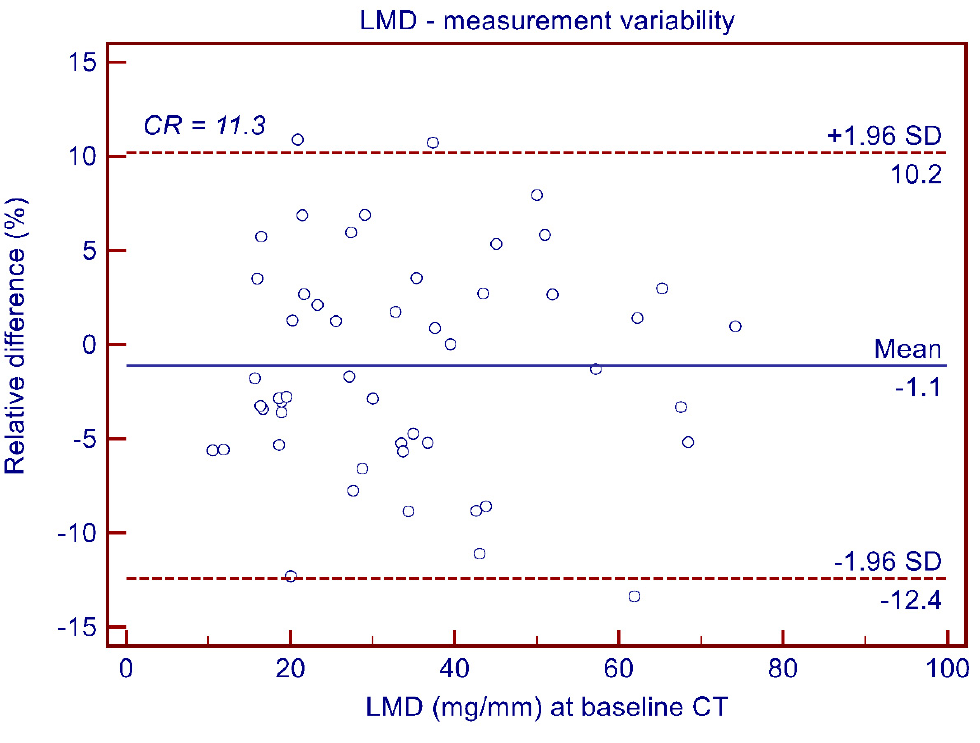
Figure 3. Bland–Altman plot showing the variability of the linear mass density (LMD) measurements. The mean difference in the LMD measurements is represented by the solid blue line. The upper and the lower limits of agreement are represented by the purple dashed lines. SD, standard deviation; CR, coefficient of repeatability.